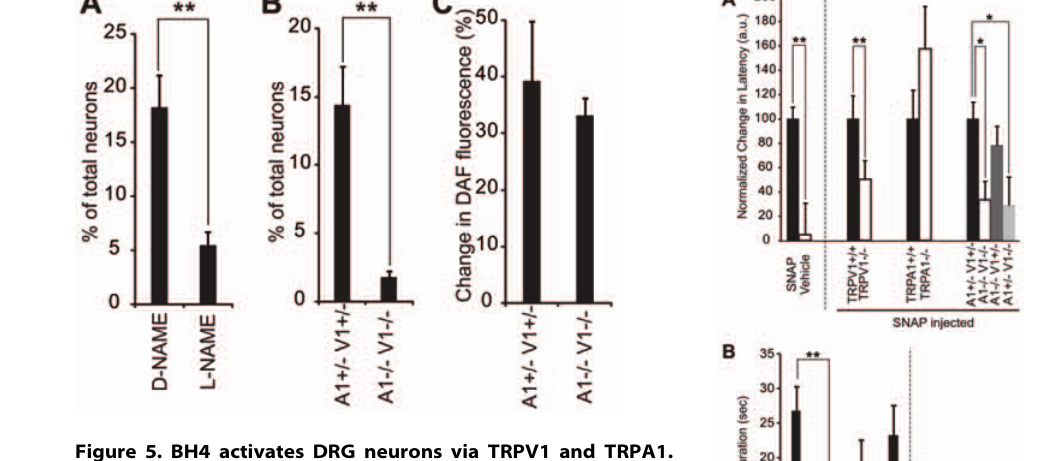
Figure 5. BH4 activates DRG neurons via TRPV1 and TRPA1. Proportion (%) of neurons activated by BH4 (1 mM) is shown. (A) DRG neurons pretreated with either L-NAME or D-NAME (200 m M, n=7 each) were challenged with BH4 for 3 min. (B) DRG neurons from TRPA1 + / 2 TRPV1 + / 2 (A1 + / 2 V1 + / 2 ) or TRPA1 2 / 2 TRPV1 2 / 2 (A1 2 / 2 V1 2 / 2 ) ani- mals were challenged with BH4 (1 mM) for 3 min. Capsaicin (10 m M) or ATP (100 m M) were applied at the end of the experiment as controls (n=6 separate experiments, see Table 3 for quantitation). (C) Increases (%) in DAF fluorescence of DRG neurons of indicated genotypes are shown (n=3 separate experiments comparing each genotype).